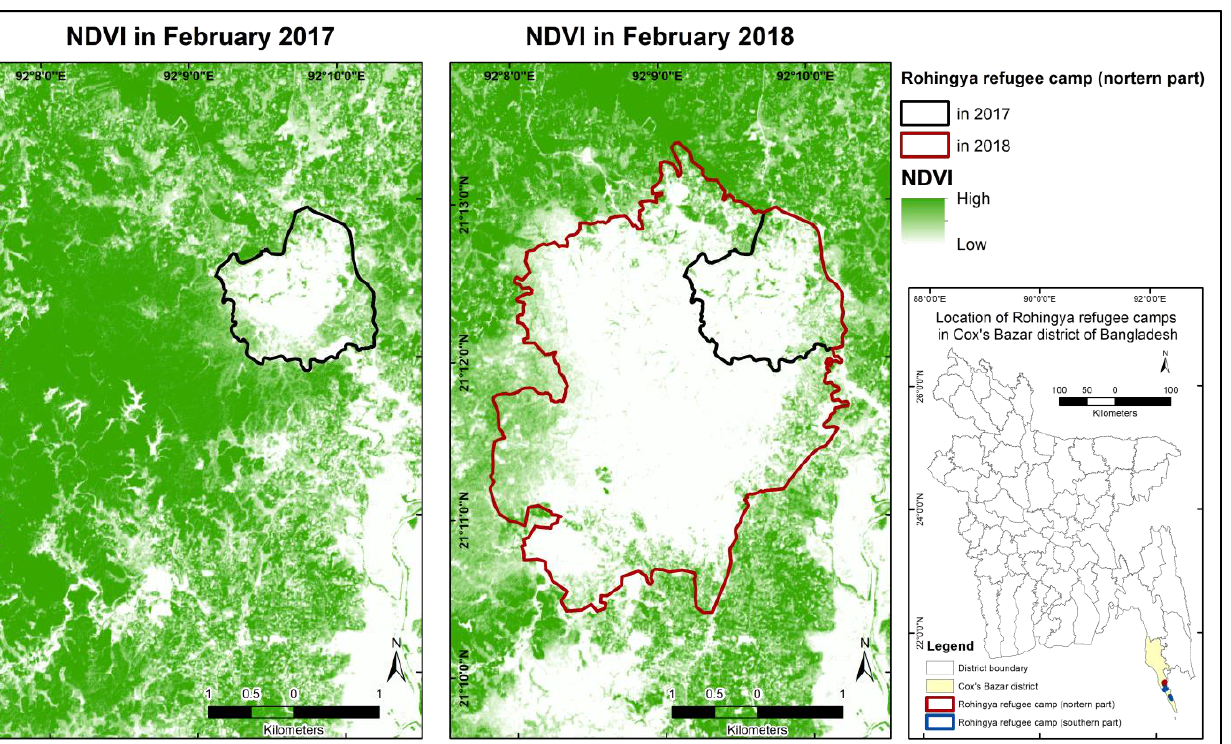
Figure 2. Change of vegetation between 2017 and 2018 as depicted by a decreased normalized difference vegetation index (NDVI). A lower NDVI means less vegetation cover.